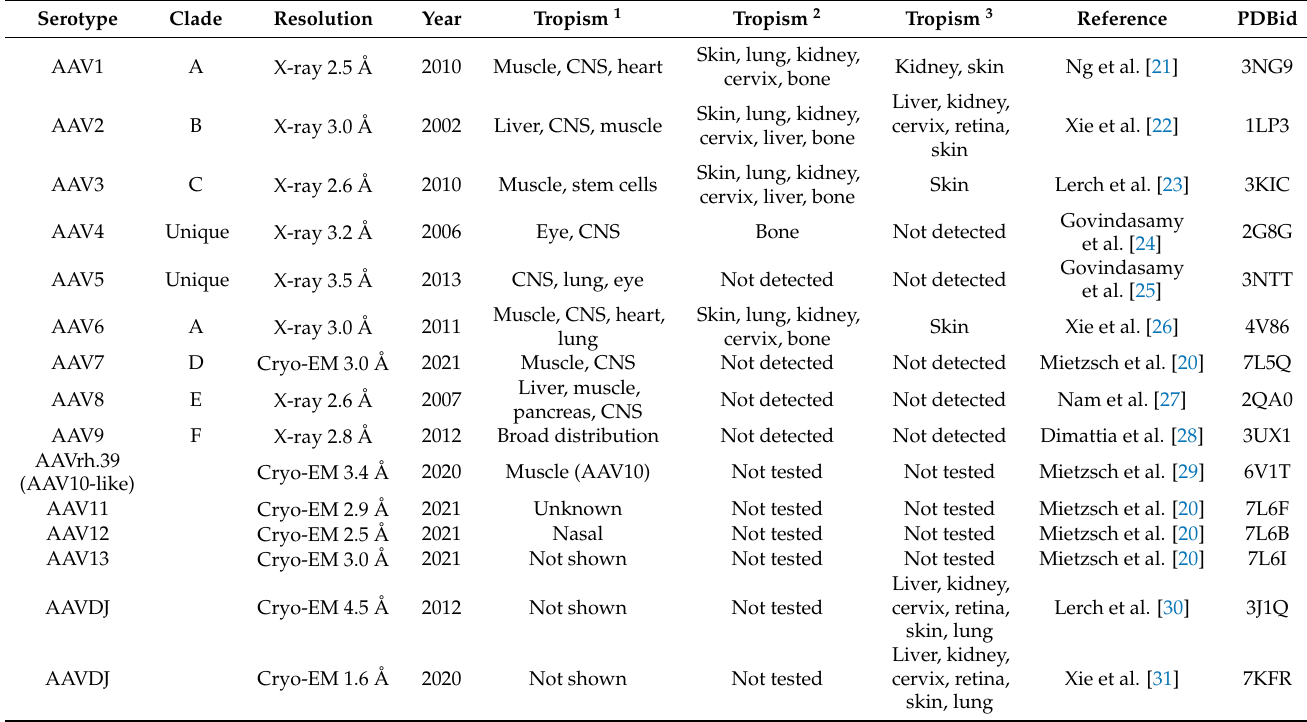
Table 1. Native AAV